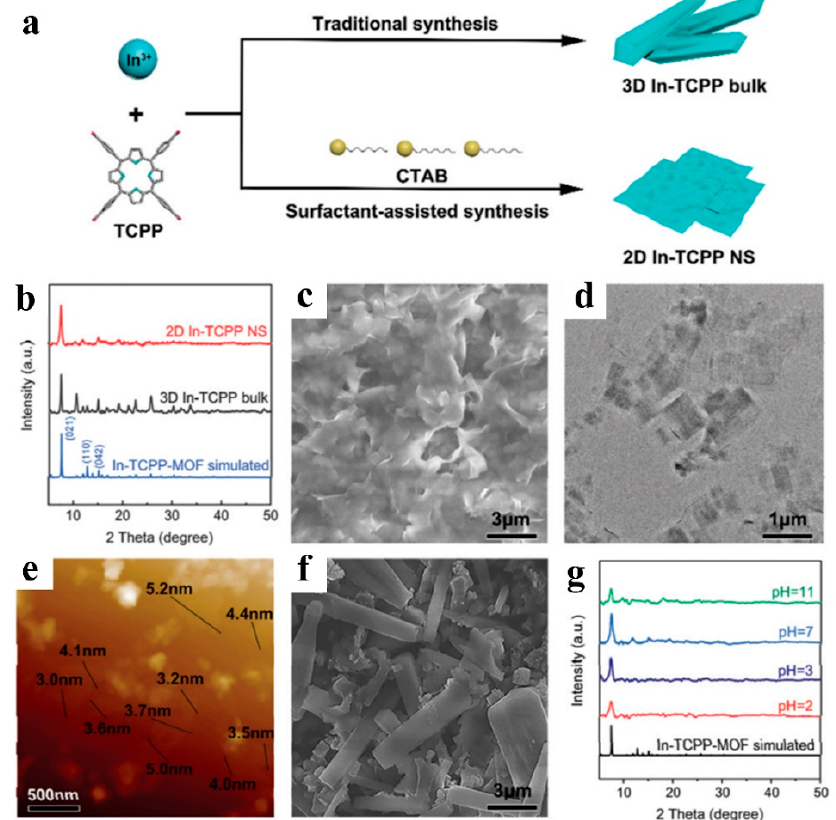
Figure 4. ( a ) Schematic diagram of synthesis for different morphologies of In-TCPP MOFs. ( b ) The powder XRD patterns for 2D In-TCPP NS and 3D In-TCPP bulk. ( c ) SEM, ( d ) TEM, and ( e ) AFM images for 2D In-TCPP NS. ( f ) The SEM image of 3D In-TCPP bulk. ( g ) The powder XRD patterns after soaking and stirring in acidic and basic solutions for 12 h. Reproduced with permission from Ref. [64].